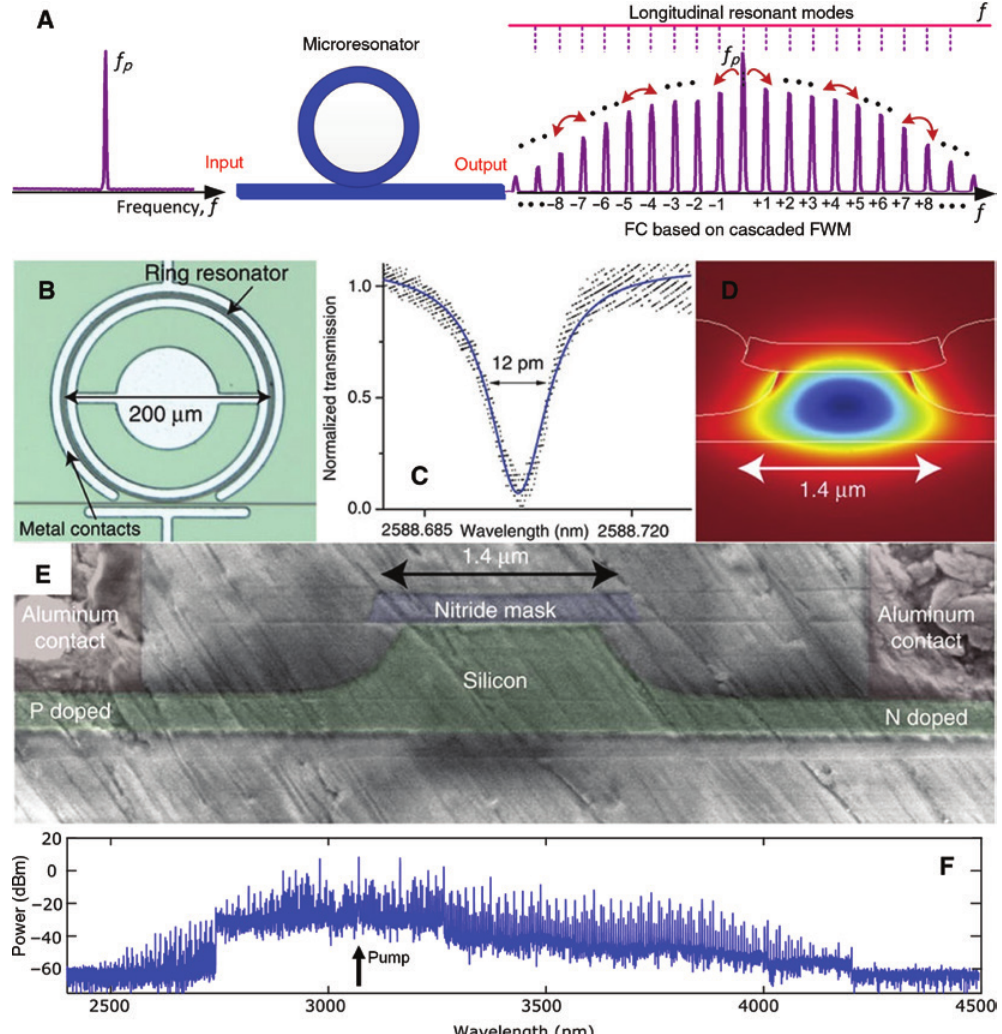
Figure 6: Mid-IR frequency comb generation in micro-resonators. (A) Schematic illustration of the frequency comb generation process in a micro-resonator via cascaded FWM, (B) top-view of an etchless